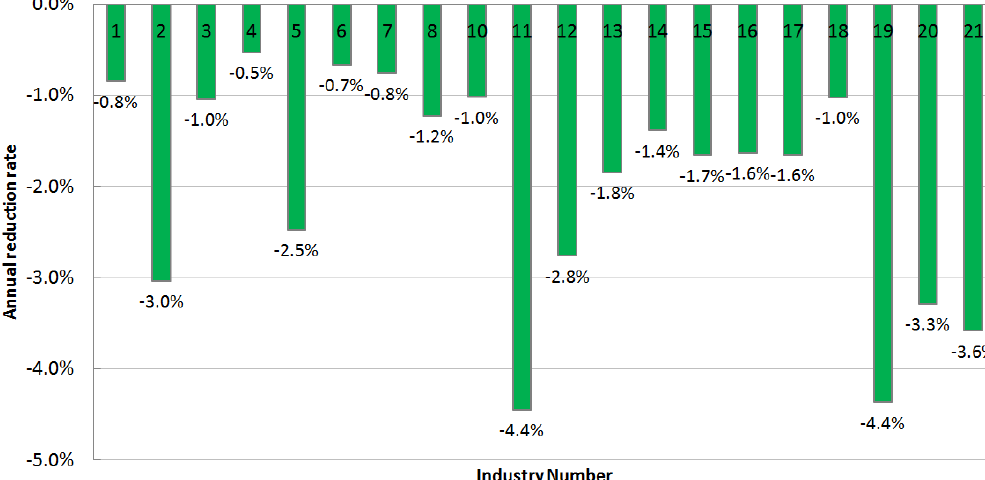
Figure 5. Annual energy consumption reduction rates needed by energy-intensive